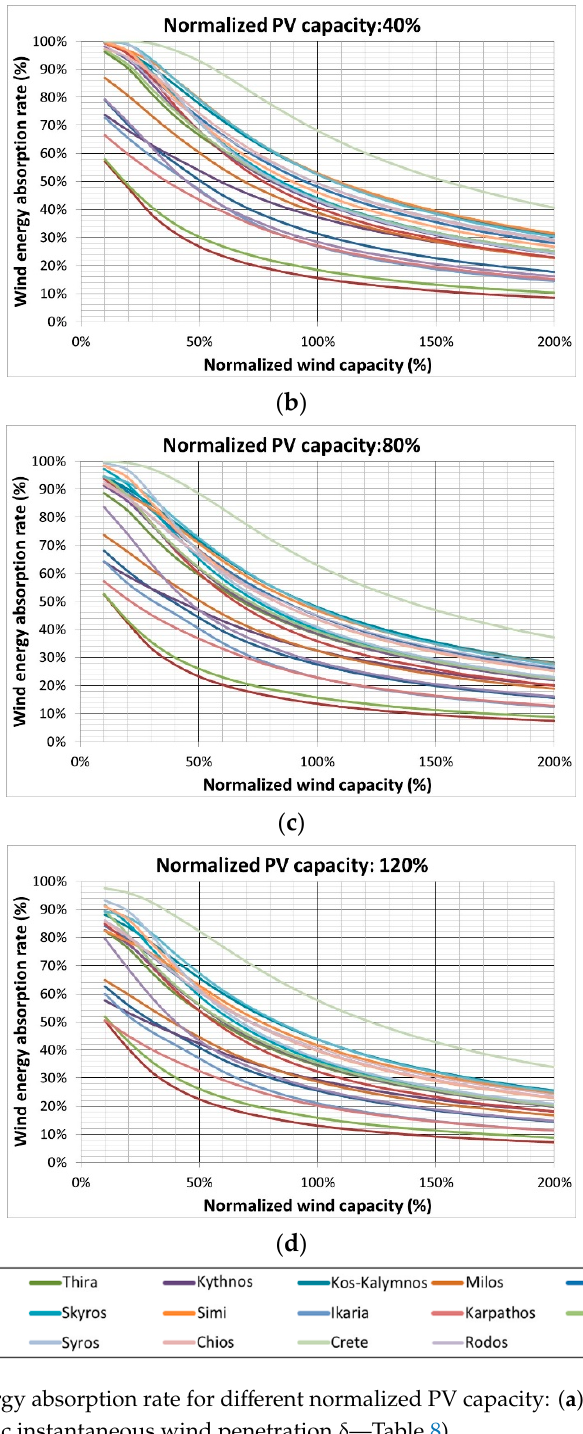
Figure 13. Wind energy absorption rate for different normalized PV capacity: ( a ) 0%, ( b ) 40%, ( c ) 80%, ( d ) 120% (case specific instantaneous wind penetration δ —Table 8).